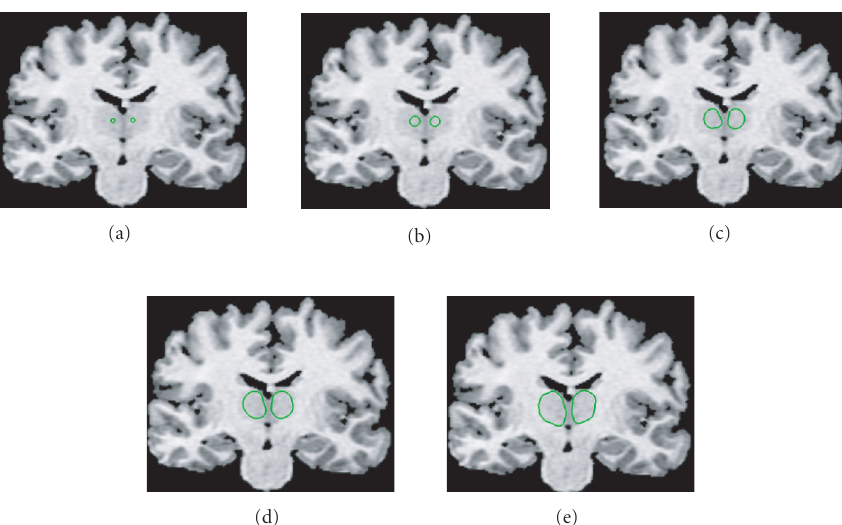
Figure 1: The model evolution process of the 2D thalamus segmentation superimposed with original image. (a) Initial seed; (b)–(d) three intermediate stages; and (e) final extracted shape.